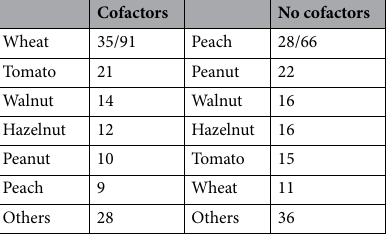
Table 3. Comparison of foods between FDEIAn and “classic” food allergy.